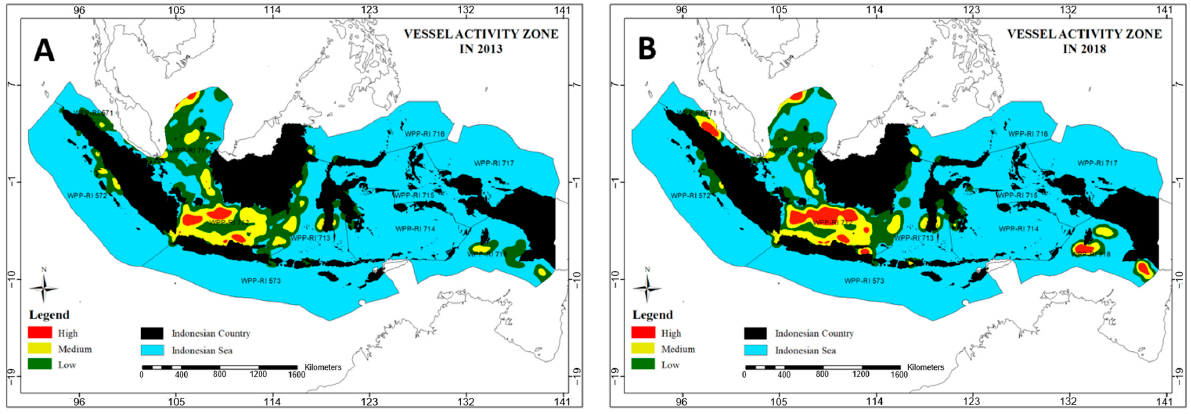
Figure 5. Maps showing the vessel activity zone in the Indonesian Fisheries Management Zone (IFMZ or WPP-RI) in 2013 and 2018. ( A ) Vessel activity zone in 2013. ( B ) Vessel activity zone in 2018.